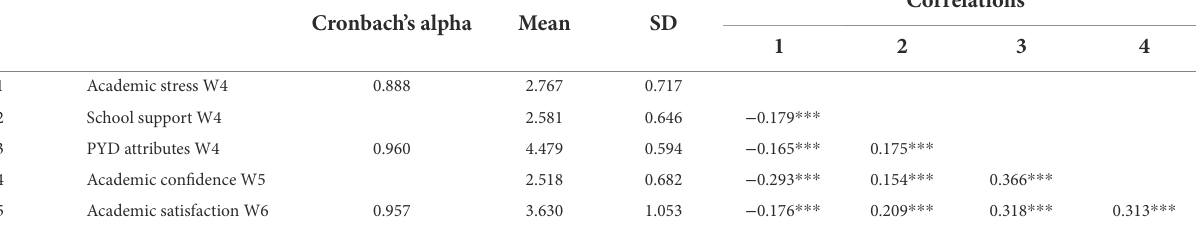
TABLE 1 Descriptive statistics and correlations.